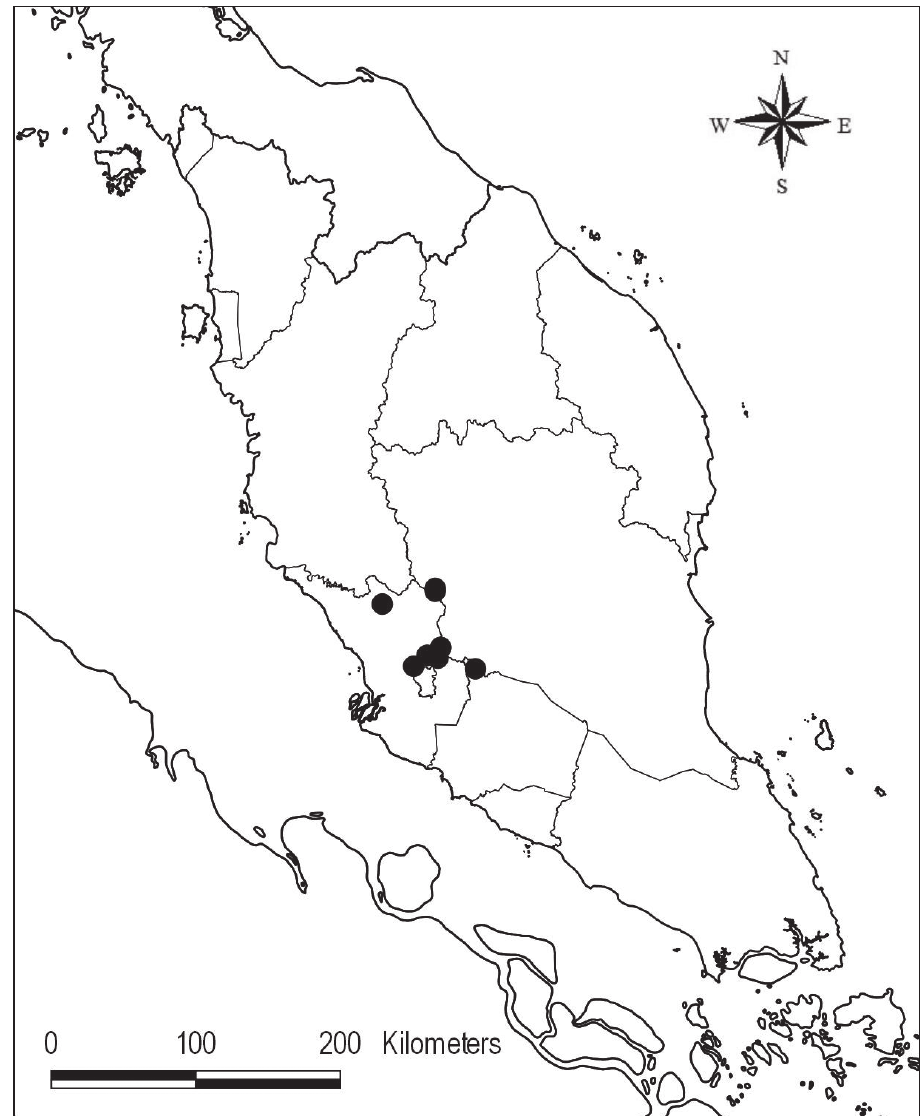
Figure 6. Distribution of Capparis trinervia var. chungiana